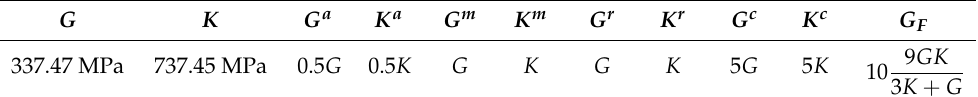
Table 1. The material parameters used to determine the mechanical properties at the nanoscale.